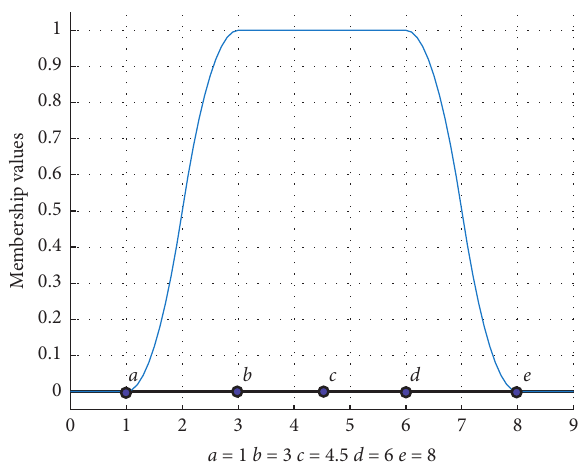
Figure 1: Π -type membership